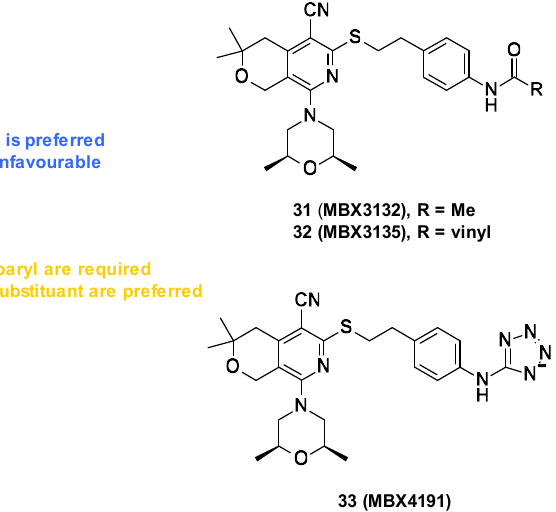
Figure 6. Structure of the hit MBX2319 ( 30 ), summary of the SARs performed, and structures of the three lead compounds.